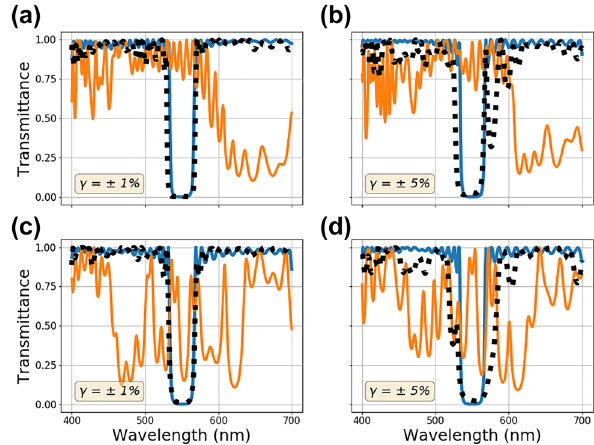
Figure 10: Multilayer stack optimization in the presence of both deterministic and random fabrication imperfections. (a) and (b) Linear gradient shift and graded transition regions between layers combined with 𝛾 = ± 1% and 𝛾 = ± 5% random index shifts, respectively (c) and (d) sinusoidal height dependent index shifts (2) with 𝛾 = ± 1% and 𝛾 = ± 5% random index shifts, respectively. The solid blue curve represents the ideally optimized spectra without any error. The orange curve represents the ideally optimized spectra after both the error types are introduced. The black dotted curve is the result of optimization to compensate for the errors.